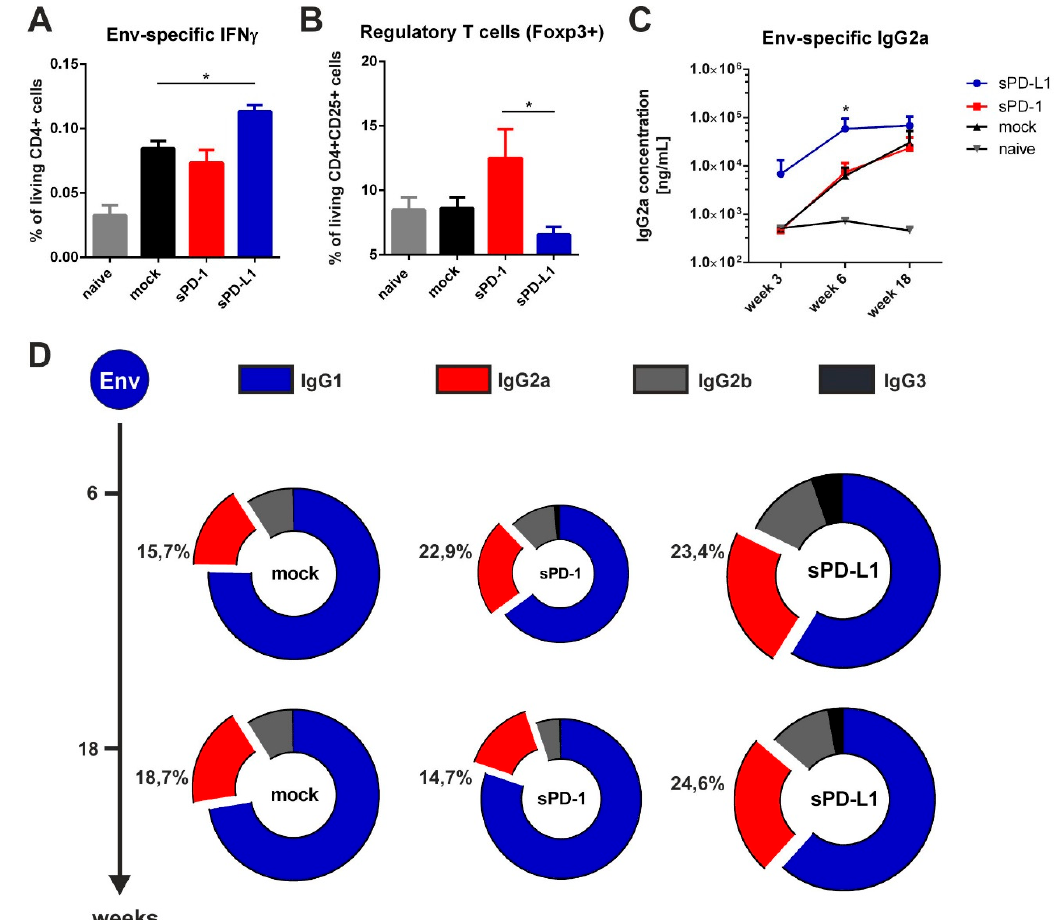
Figure 6. Soluble PD-L1 ectodomain co-expression enhances Env-specific immune responses. ( A